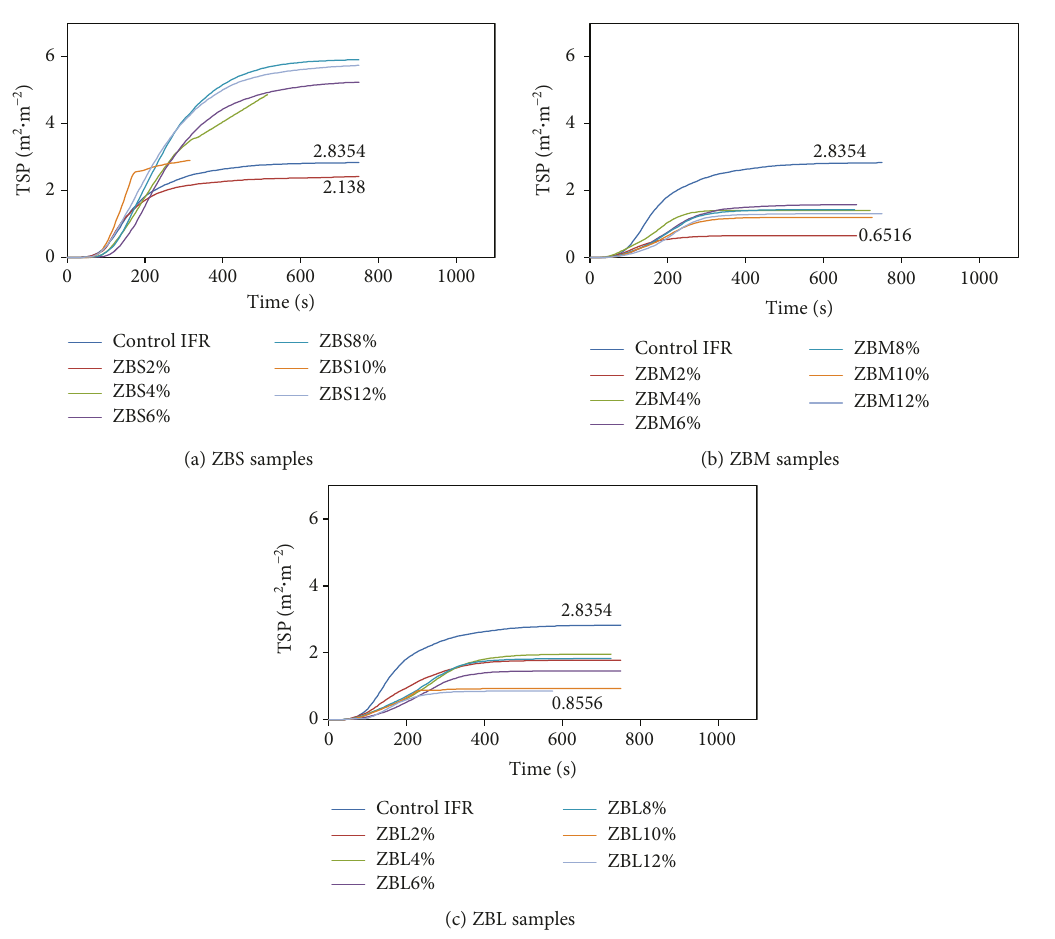
Figure 5: Total smoke production of wood treated with IFR/ZB coatings.